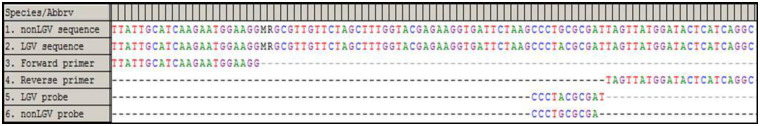
Alignment of primers and probes for the CT-LGV typing PCR targeting the pgp3 PCR.For the position of the LNA bases see Table 1.